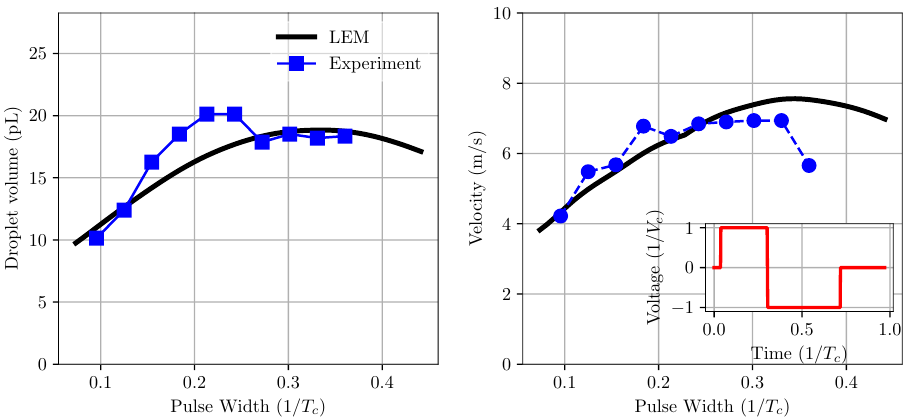
Figure 14. Variation of droplet volume and velocity with pulse width in comparison with experi- ment measurement. The on-pulse condition predicted from the model is in good agreement with experimental data of about 0.3 T c .